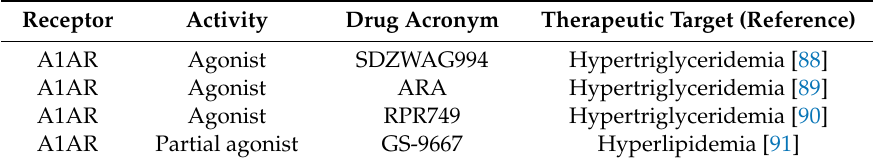
Table 2. A1AR Modulators Trialed in